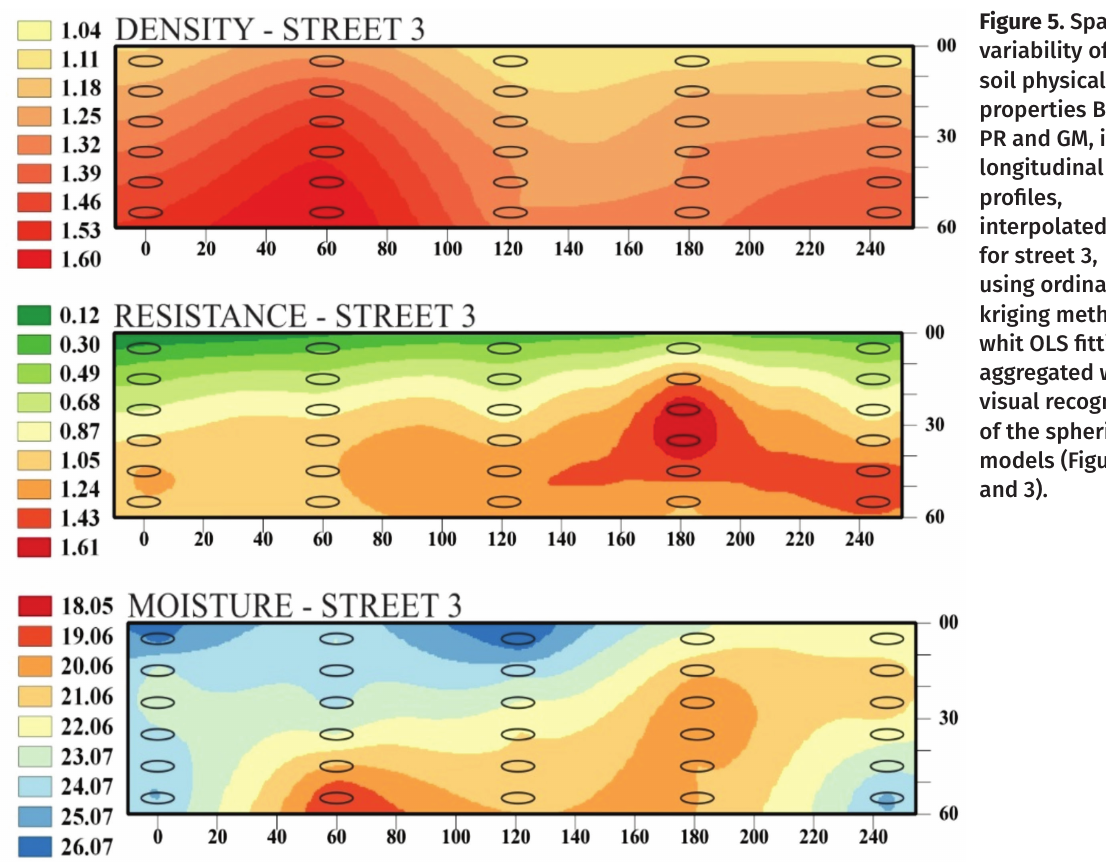
Figure 5. Spatial variability of soil physical properties BD, PR and GM, in longitudinal profiles, interpolated for street 3, using ordinary kriging method whit OLS fitting, aggregated with visual recognition of the spherical models (Figures 2 and